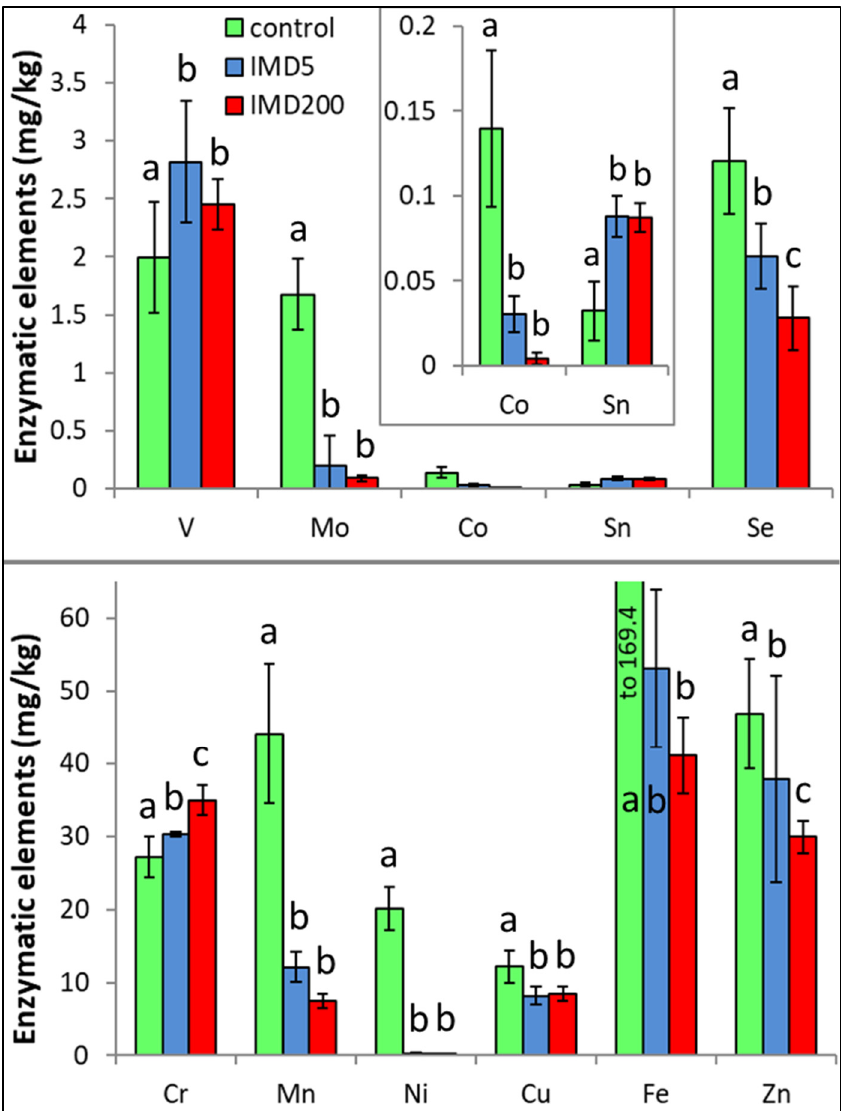
Figure 4. Body levels (mean ± SD) of the enzymatic bioelements in honey bee workers exposed and unexposed to imidacloprid. Explanations: control = the bees were fed a diet without imidacloprid; IMD5 = the bees were fed a diet with a 5 ppb addition of imidacloprid; IMD200 = the bees were fed a diet with a 200 ppb addition of imidacloprid. Different lowercase letters = differences between the means nested within each bioelement are significant (ANOVA + LSD; p < 0.05).